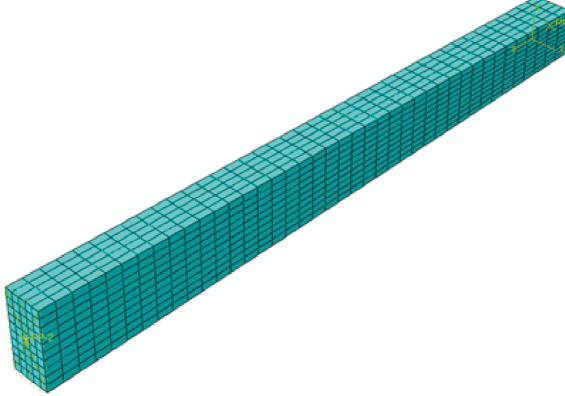
Figure 3: FE model developed by ABAQUS program. Table 2: Comparison between the FE model results and the proposed model results.